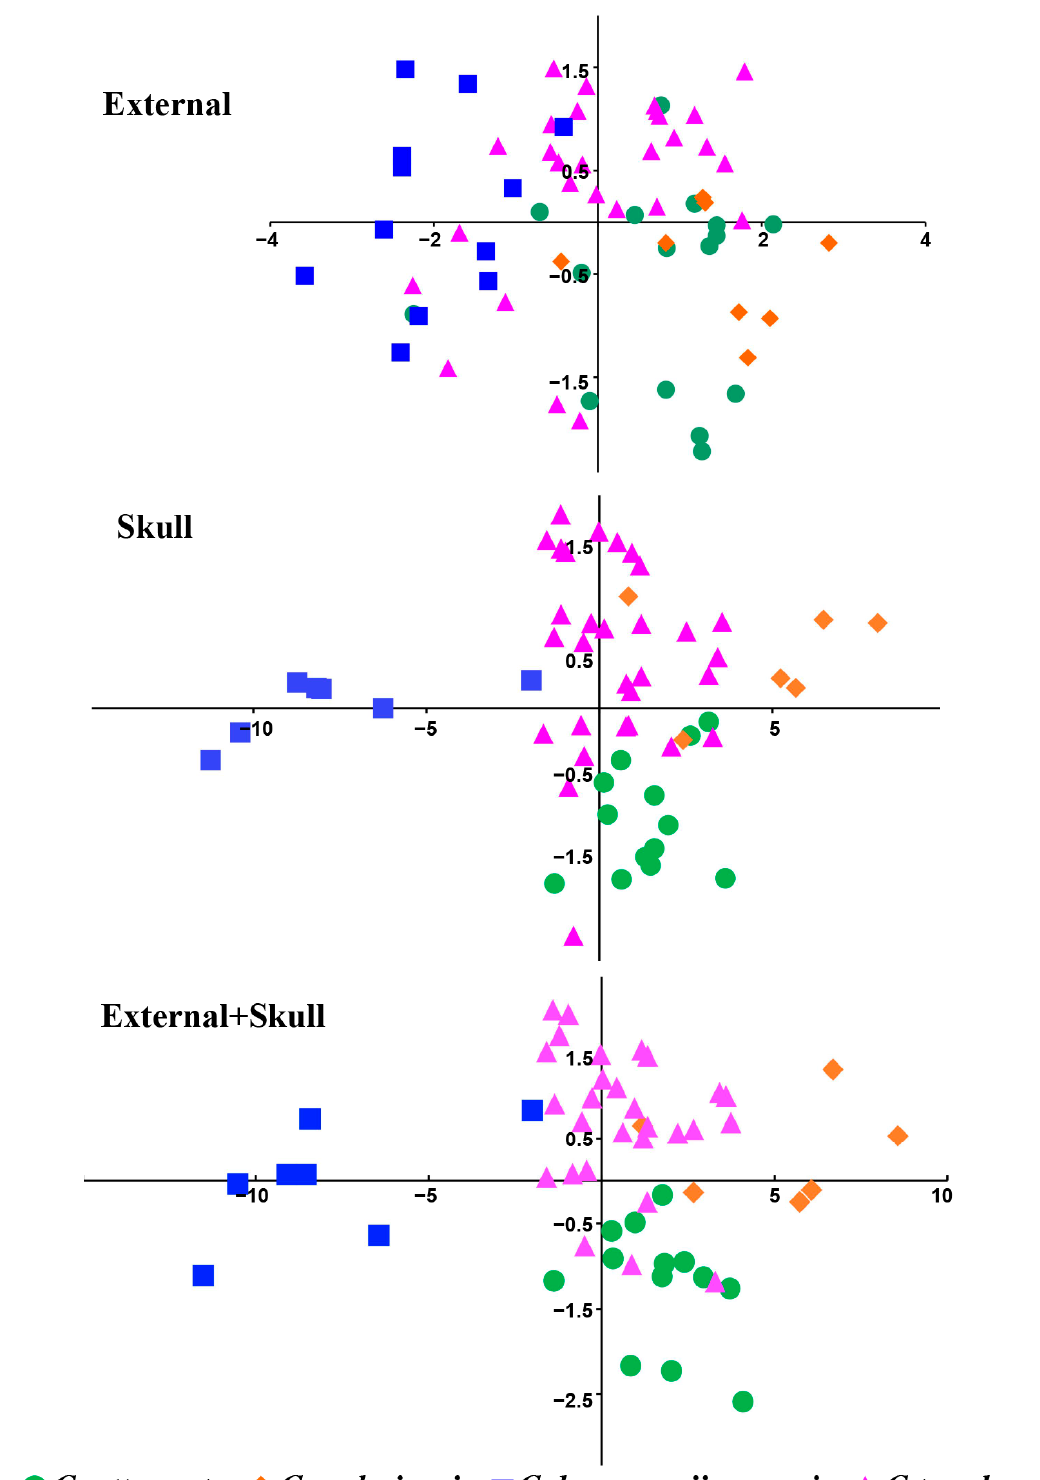
Figure 4. Principal component plots of C. attenuata species complex.